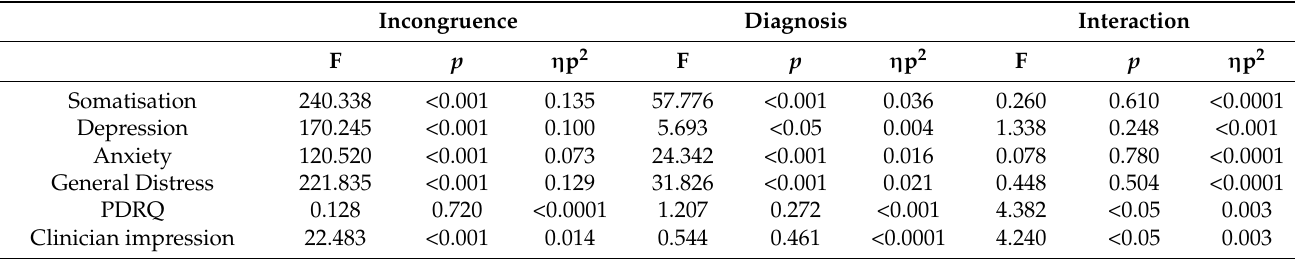
Table 4. General linear